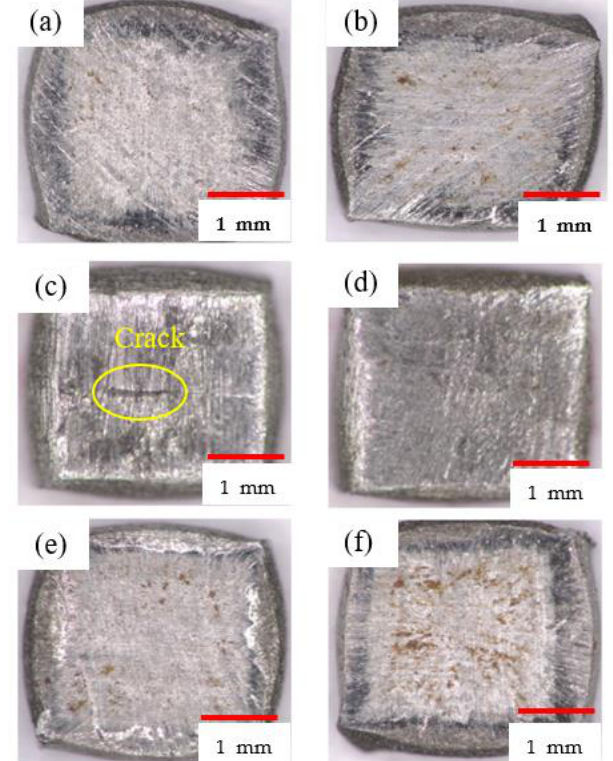
Figure 12. Images of the specimens heat-treated under different conditions after the compression test along the ND: ( a ) alloy B 800 °C, 6 min, ( b ) Gr.92 800 °C, 6 min, ( c ) alloy B 1050 °C, 6 min, and 800 °C, 6 min ( d ) Gr.92 1050 °C, 6 min, and 800 °C, 6 min, ( e ) alloy B 1150 °C, 6 min, and 800 °C, 6 min, and ( f ) Gr.92 1150 °C, 6 min, and 800 °C, 6 min.